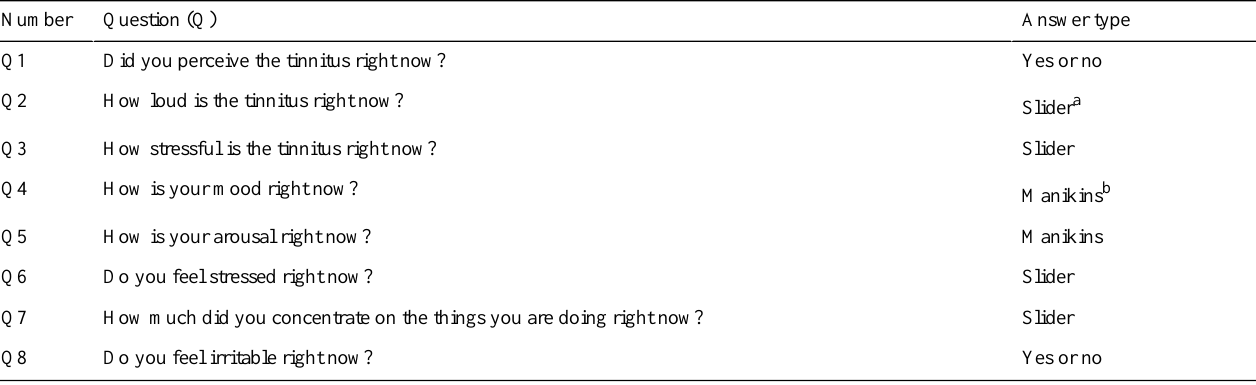
Table 1. Questions from the dynamic ecological momentary assessment (EMA-D)